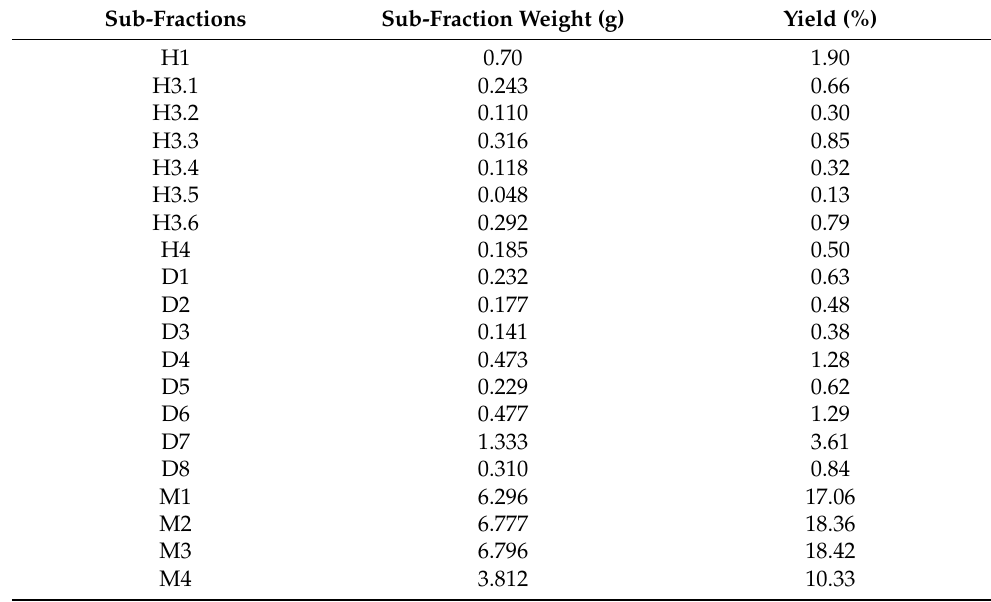
Table 1. Percentage yields of sub-fractions of U. gallii with respect to the crude methanol extract.